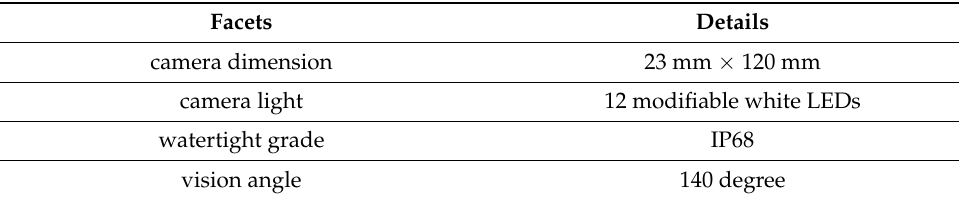
Table 1. Specifications of a utilized sewer camera.